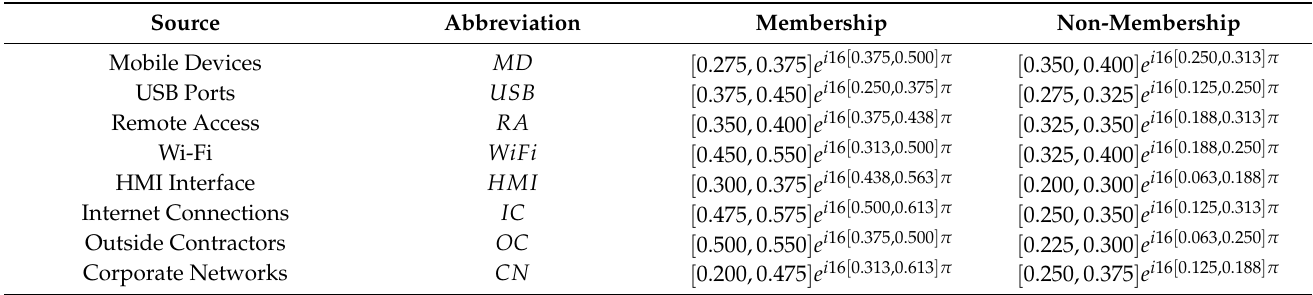
Table 2. Details of code penetration